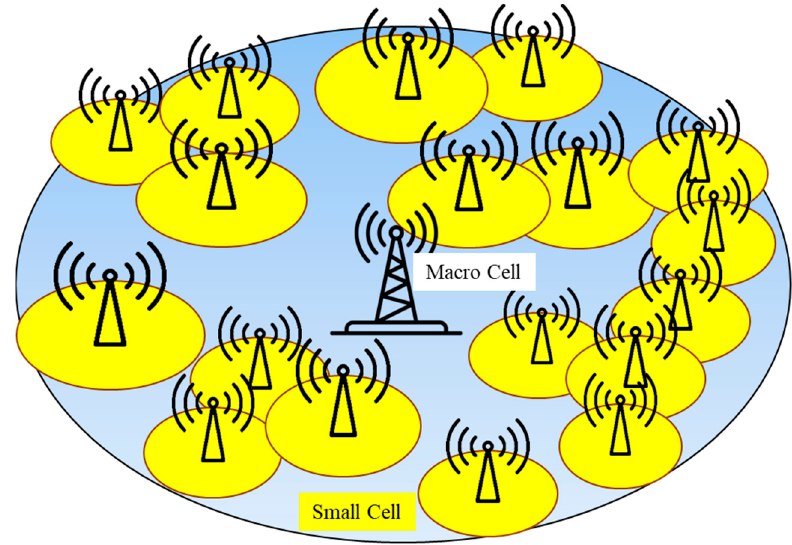
Figure 1. 5G UDN